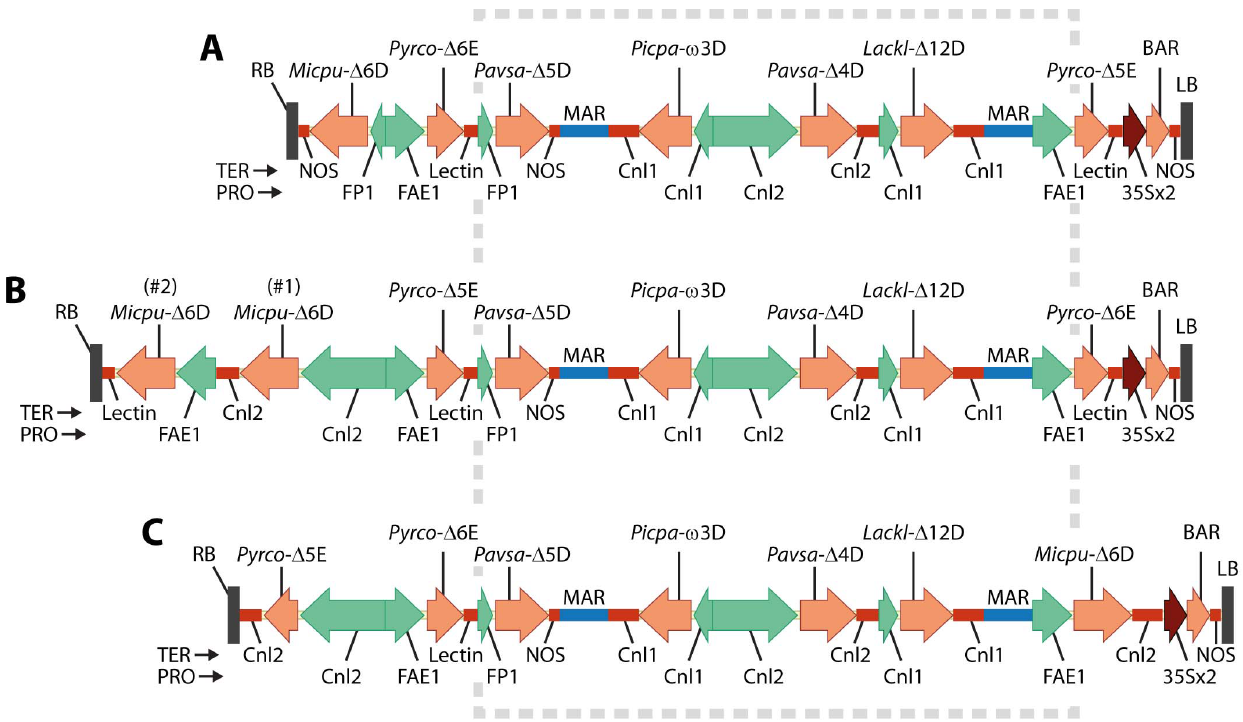
Figure 2. DHA pathway construct maps described in this study: A) GA7 parental construct; B) mod-F variant with an additional D 6- desaturase, elongase coding regions switched and the original FP1 promoter replaced by Cnl2; C) mod-G with the D 5-elongase and D 6-desaturase coding regions switched. The box denotes the unchanged region. Abbreviations are: TER, terminator or polyadenylation region; PRO, promoter; NOS, Agrobacterium tumefaciens nopaline synthase terminator; FP1, Brassica napus truncated napin promoter; FAE1, Arabidopsis thaliana FAE1 promoter; Lectin, Glycine max lectin terminator; Cnl1 and Cnl2 denotes the Linum usitatissimum conlinin1 or conlinin2 promoter or terminator. MAR denotes the Rb7 matrix attachment region from Nicotiana tabacum and gene identities are given in the text and the Materials and Methods section. doi:10.1371/journal.pone.0085061.g002 PLOS ONE |